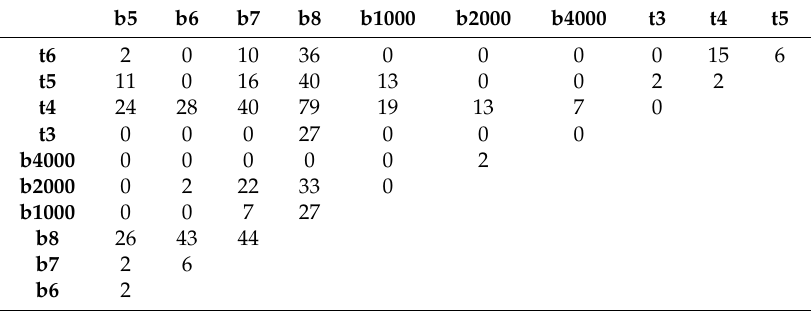
Table 5. Significant difference scores (%) between each tested method (laboratory study). Table 4. Significant difference scores (%) between each tested method (field